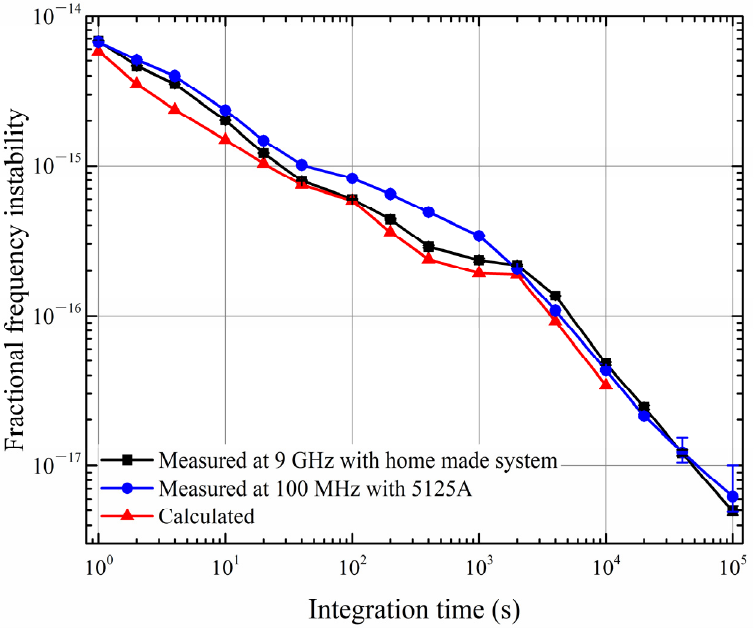
Figure 7. Transfer instability of 200-km cascaded compensated link composed of a first span and a third span.